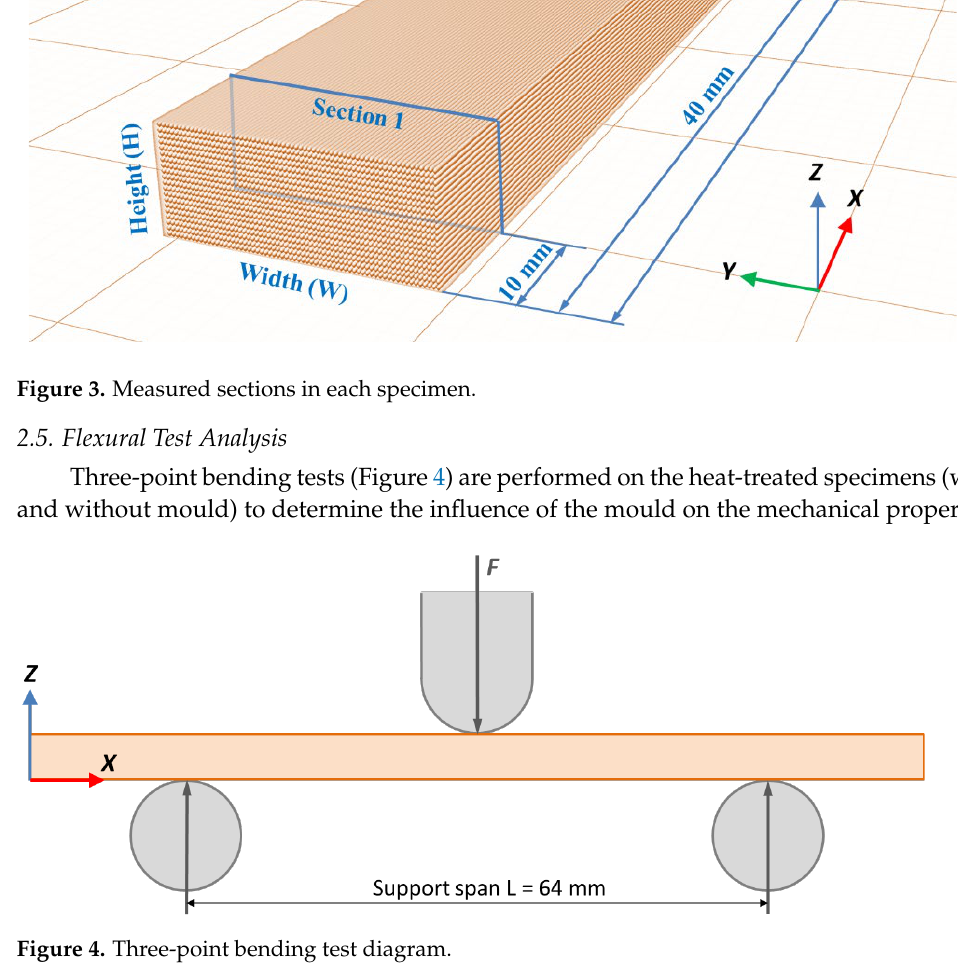
Figure 3. Measured sections in each specimen.